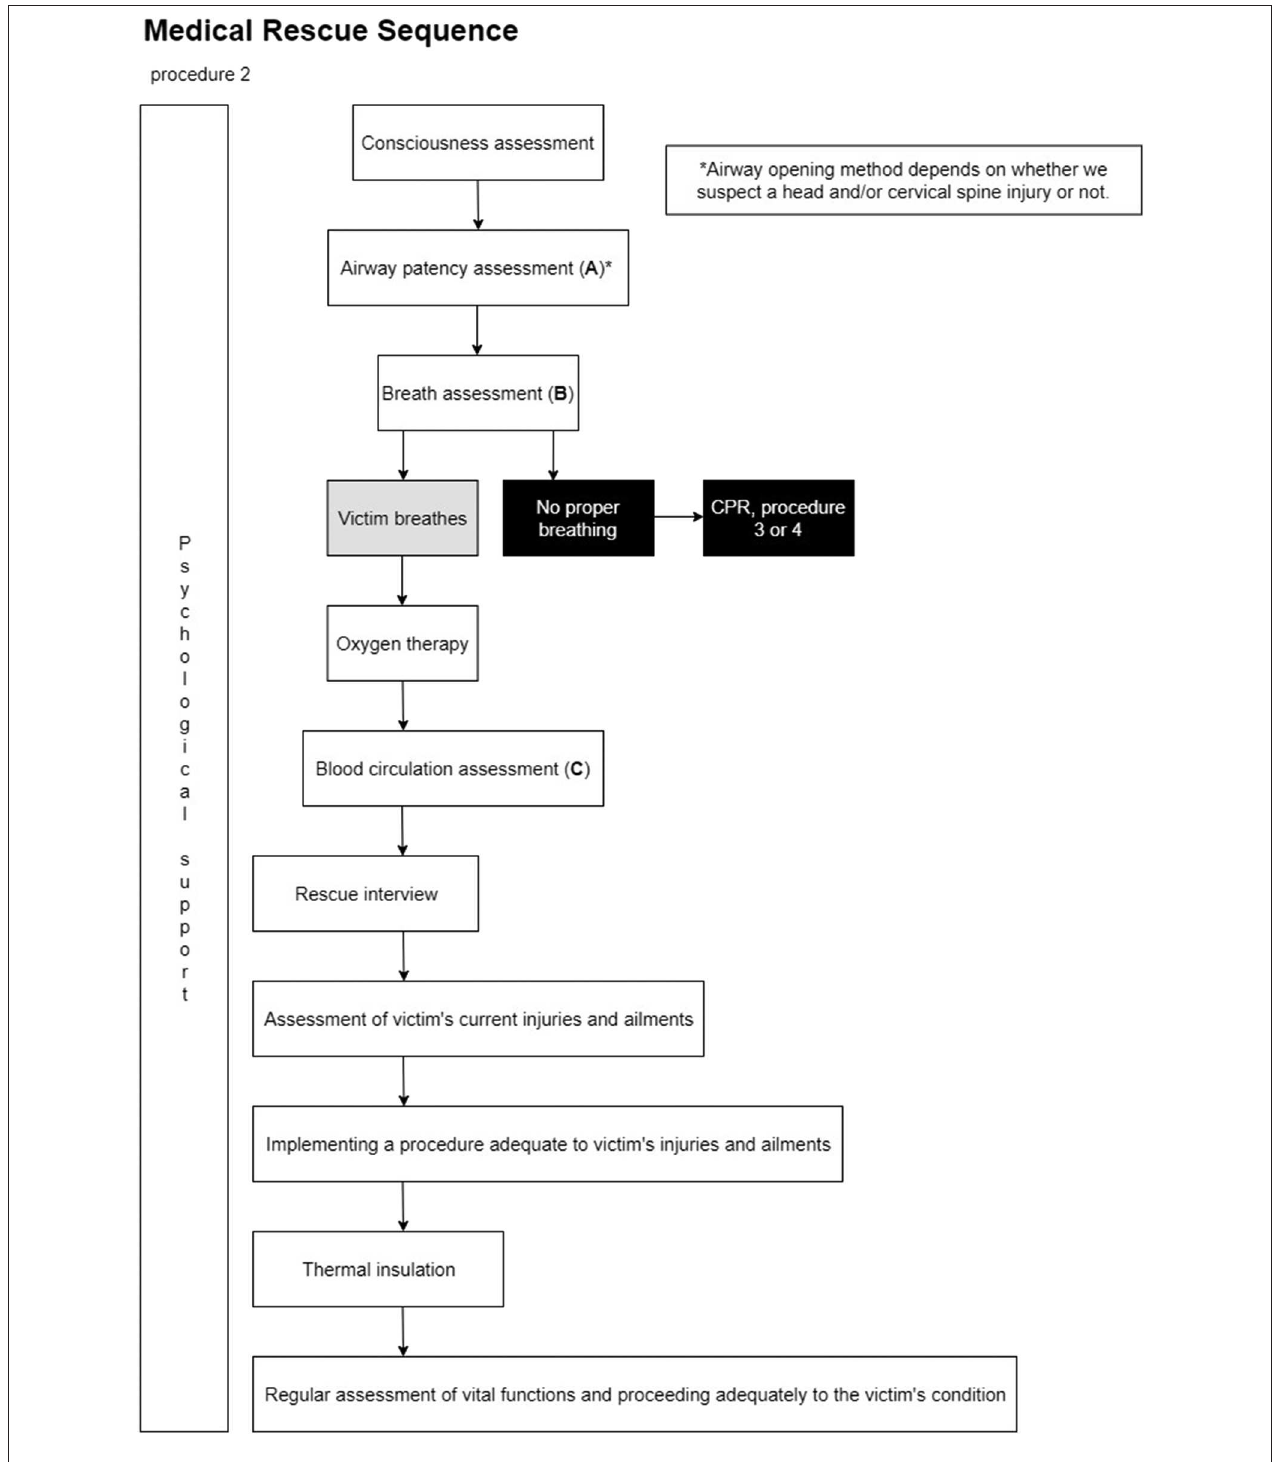
FIGURE 1 | The medical rescue sequence used for the experimental task in the